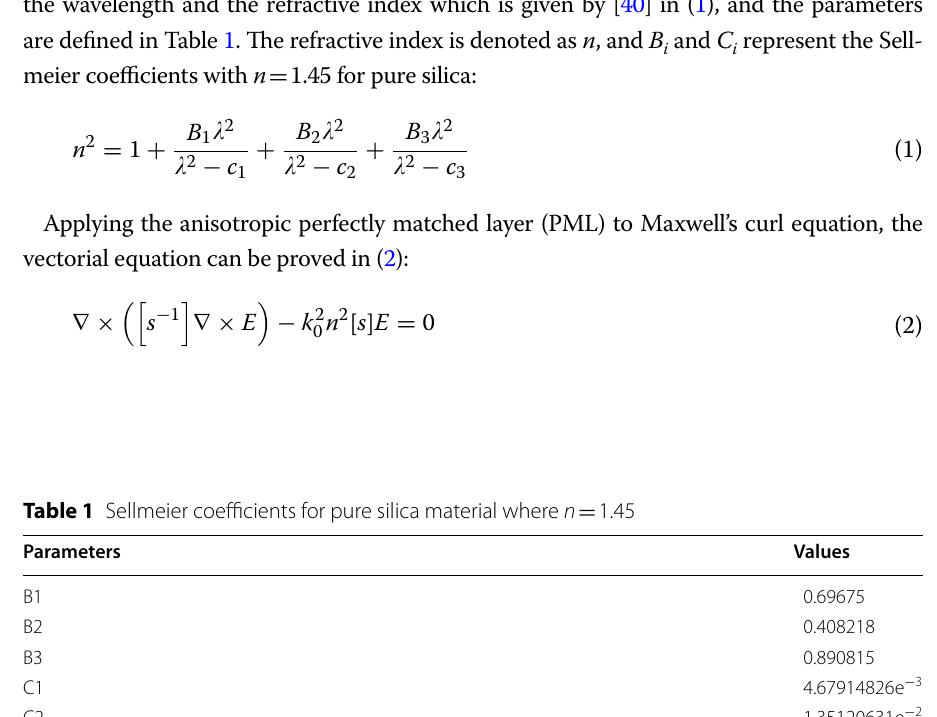
Table 1 Sellmeier coefficients for pure silica material where n Parameters Values